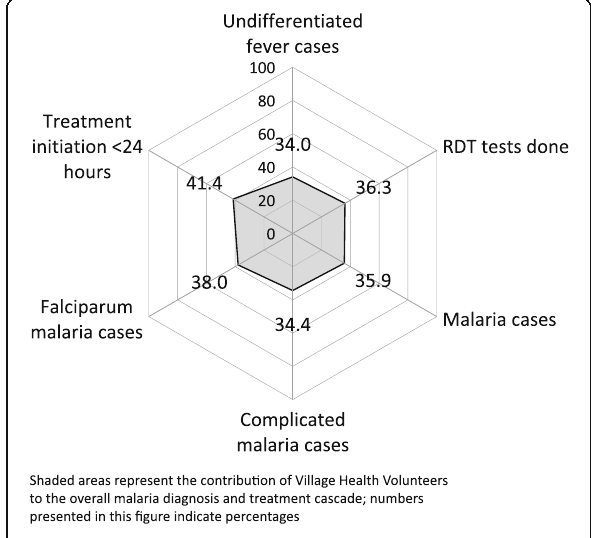
Fig. 4 Contribution of village health volunteers in malaria diagnosis and treatment activities under the National Malaria Control Programme in Myanmar, 2016